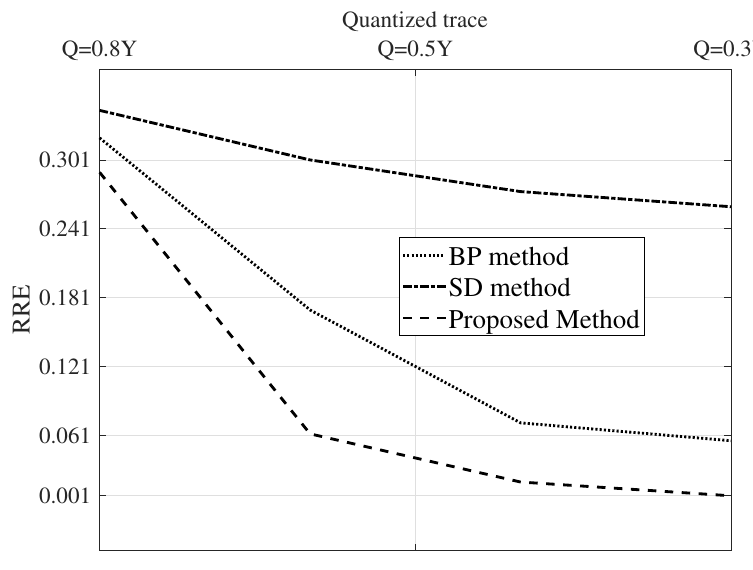
Figure 9. Quality ( Q ) versus SNR with 20